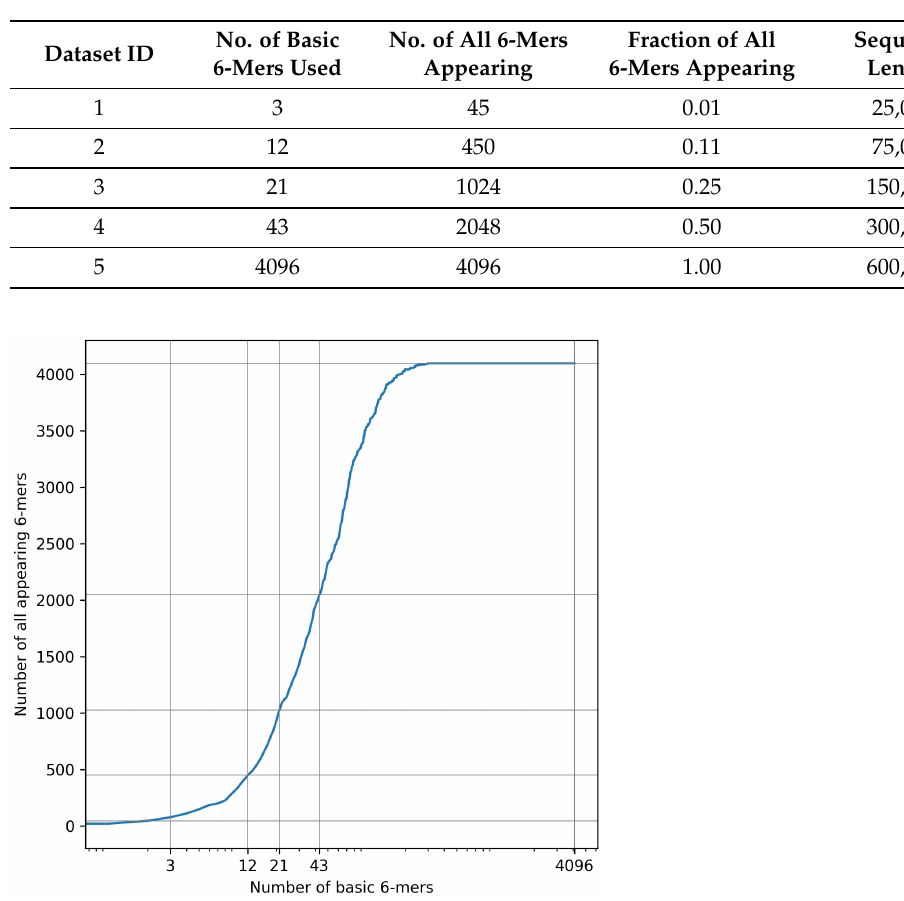
Table 1. Details of reduced simulated datasets.